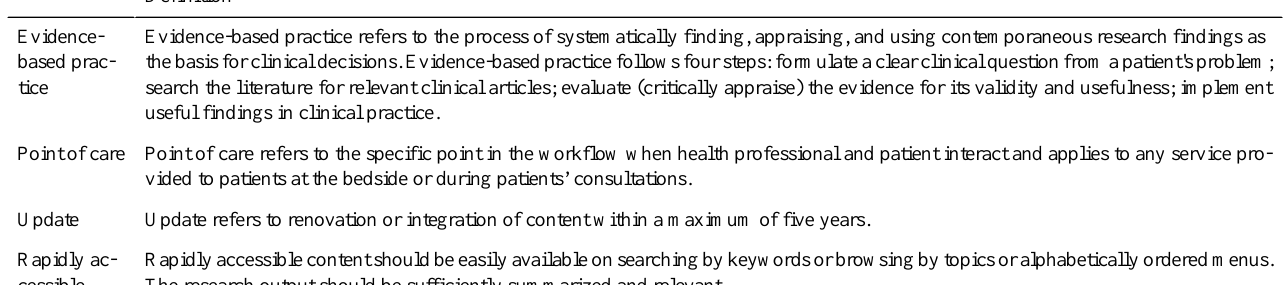
Table 1. Definitions helpful to explain criteria for inclusions and exclusions